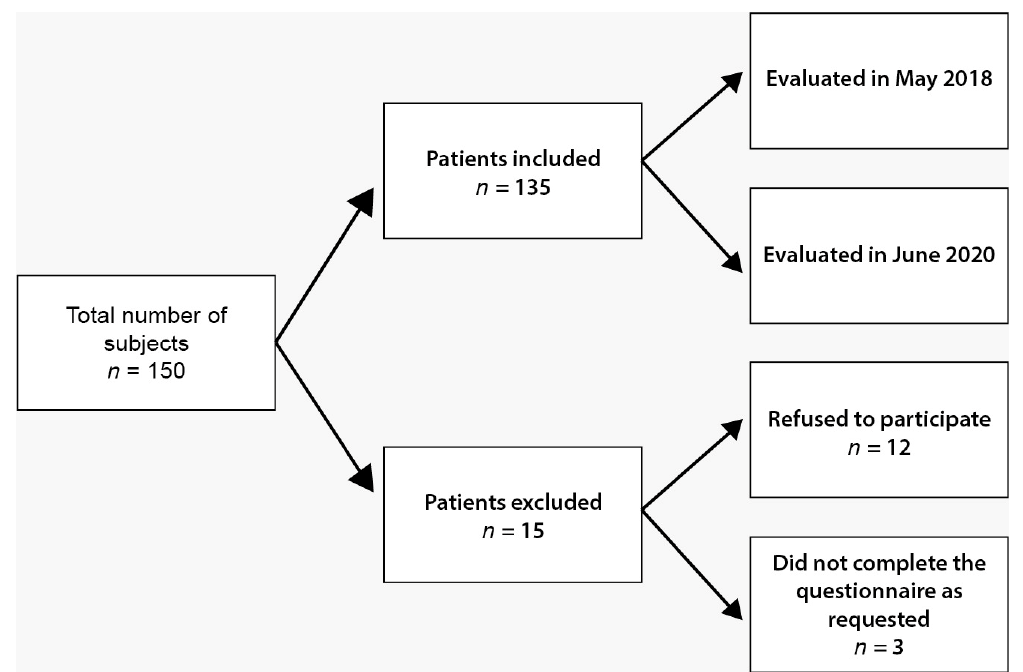
Figure 1. Study flowchart regarding inclusion and exclusion criteria.